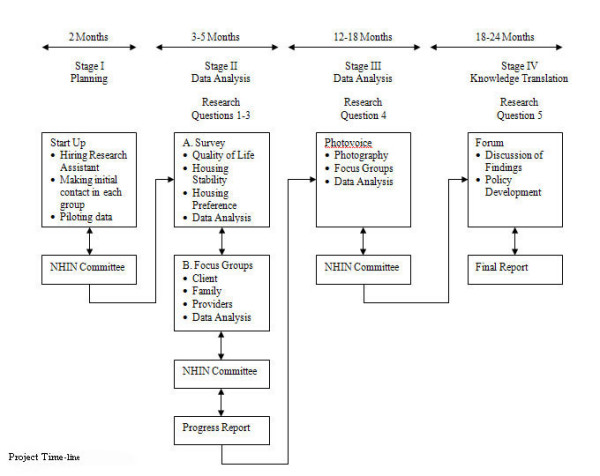
Project time-line.